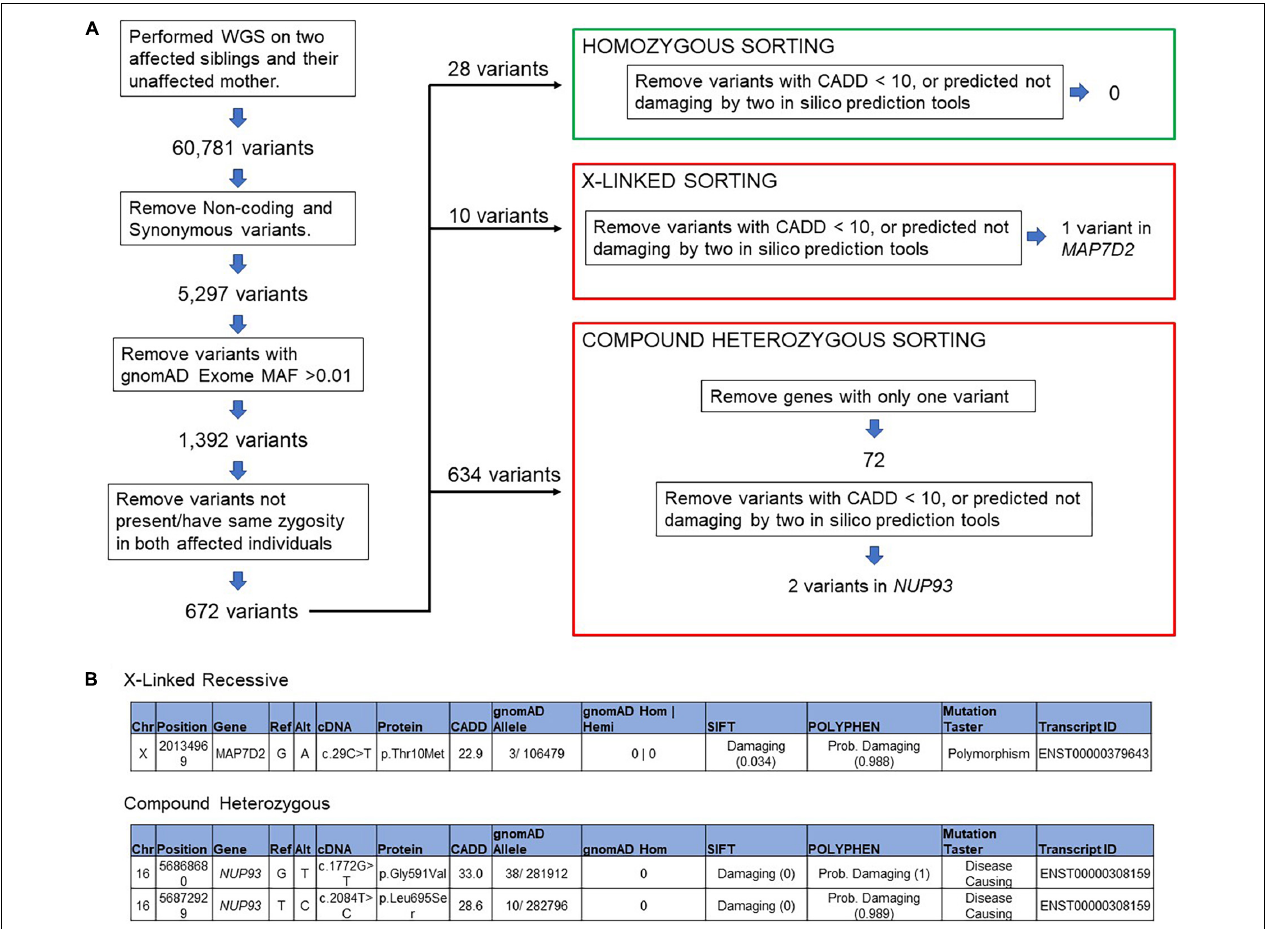
FIGURE 2 | Filtering algorithm (A) variant filtering of the whole genome sequencing data in patient with collapsing FSGS, (B) segregating variants of unknown significant was identified in MAP7D2 and a compound heterozygous variant in